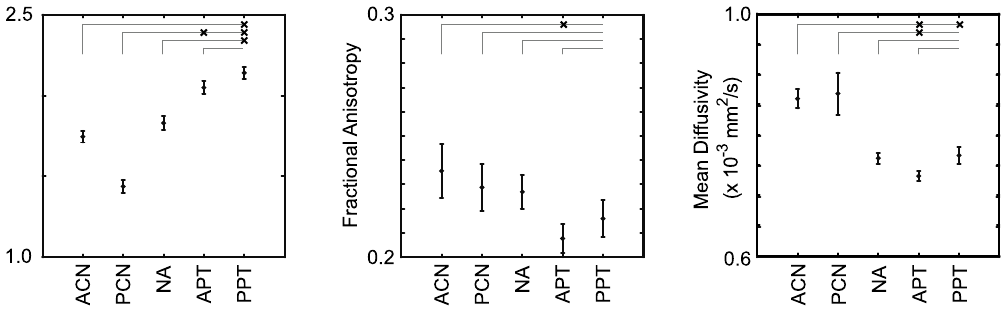
Figure 1. Subregional differences in dopamine synthesis capacity, fractional anisotropy and mean diffusivity in the striatum evaluated by Friedman’s test ( a =0.05). The cross (x) represents statistically significant difference between two regions. Error bar shows standard error of means.